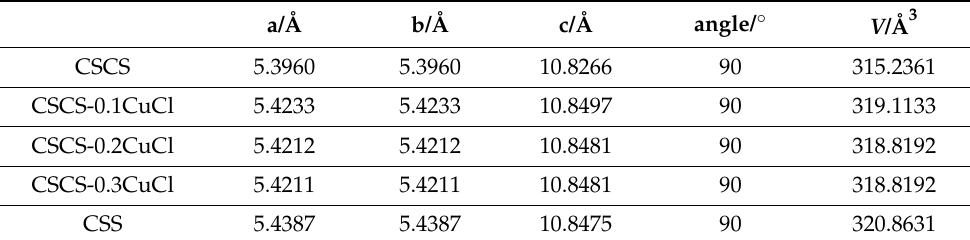
Table 1. The lattice parameters variation against the excess amount of Cu, x , for the CSCS- x CuCl ( x = 0, 0.1, 0.2, 0.3) and CSS samples. a/Å b/Å c/Å angle/ ◦ V /Å 3